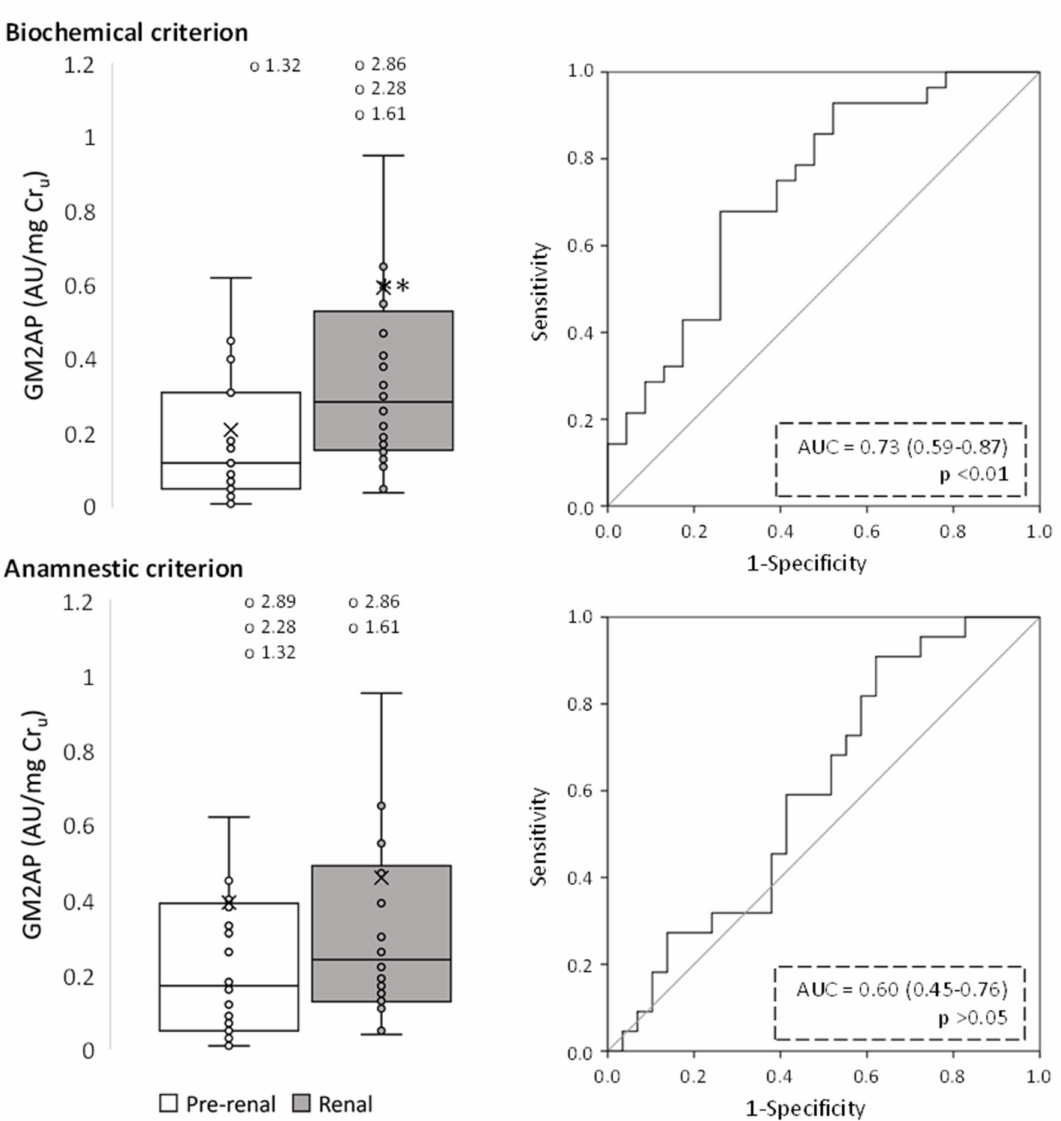
Figure 2. Urinary GM2AP levels of pre-renal and renal AKI patients following classification by biochemical and anamnestic criteria, shown as box plots ( left panels) representing median values in arbitrary units (AU) of urinary GM2AP per mg urinary creatinine (Cr u ), and ROC curves ( right panels). AUC: area under the ROC curve showing the pre-renal/renal classification efficacy of urinary GM2AP. The × in box plots represents the median value. **, p <